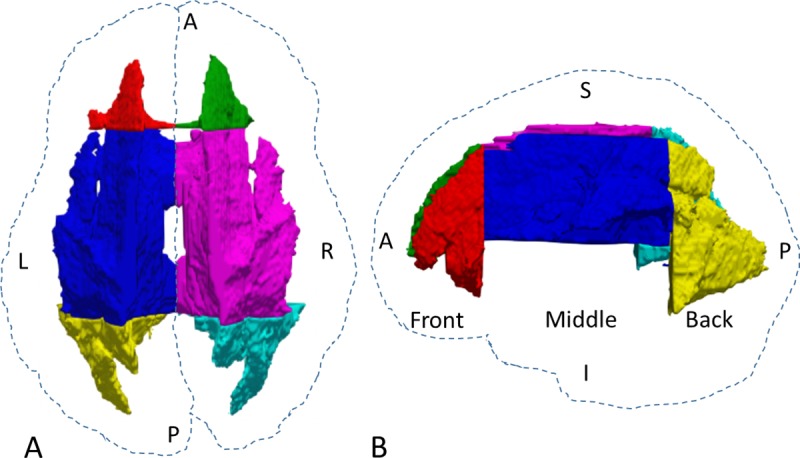
Three regions of interests in the white matter.(A) Top view. (B) Side view. The dashed contours are based on the whole brain. L, left; R, right; A, anterior; P, posterior; S, superior; I, inferior.